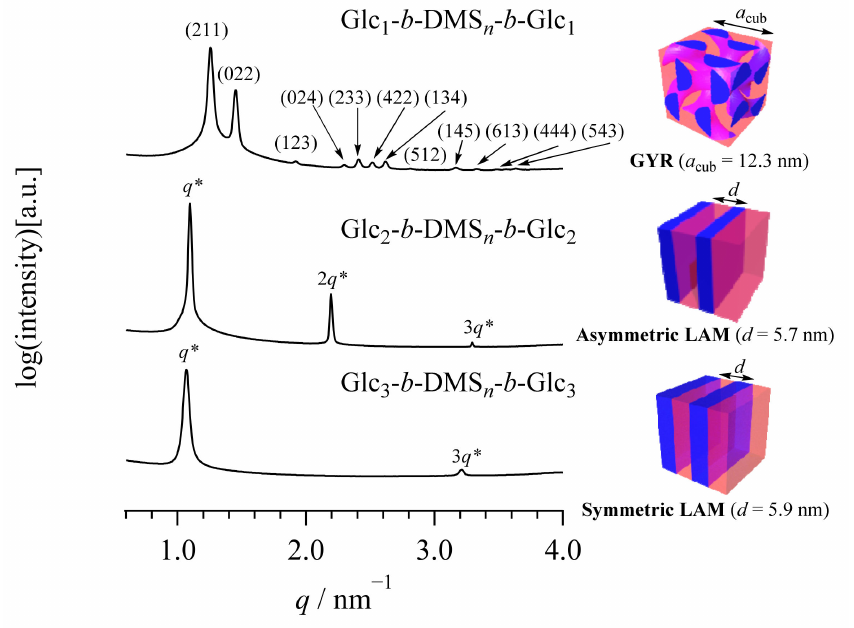
Figure 2. SAXS profiles of Glc 1 - b -DMS n - b -Glc 1 ( upper ), Glc 2 - b -DMS n - b -Glc 2 ( middle ), and Glc 3 - b - DMS n - b -Glc 3 ( lower ). All samples were annealed at 80 ◦ C for 6 h. The cubic lattice parameter a cub for the GYR was calculated based on a cub = 2 π ( h 2 + k 2 + l 2 ) 1/2 / q hkl and the d value for the LAM was calculated based on Bragg’s equation: d = 2 π / q *